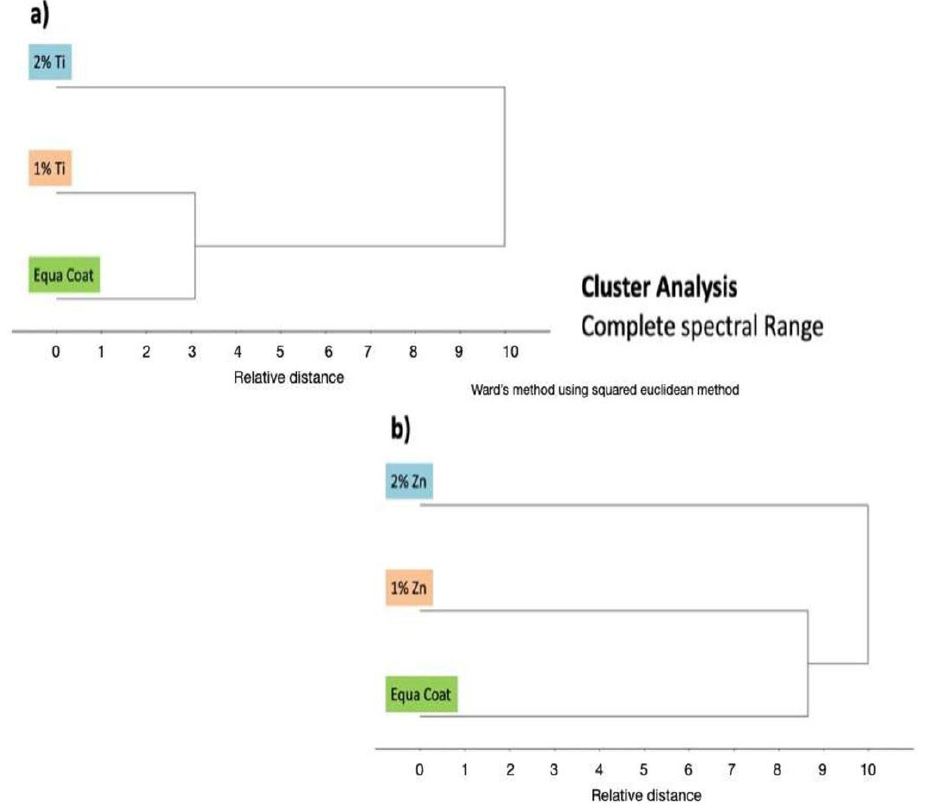
Figure 3. Cluster analysis (CA) at complete spectral range. ( a ) EQUIA coat (E), 1% TiO 2 (ET1), and 2% TiO 2 (ET2) ( b ) EQUIA coat (E), 1% ZnO (EZ1), and 2% ZnO